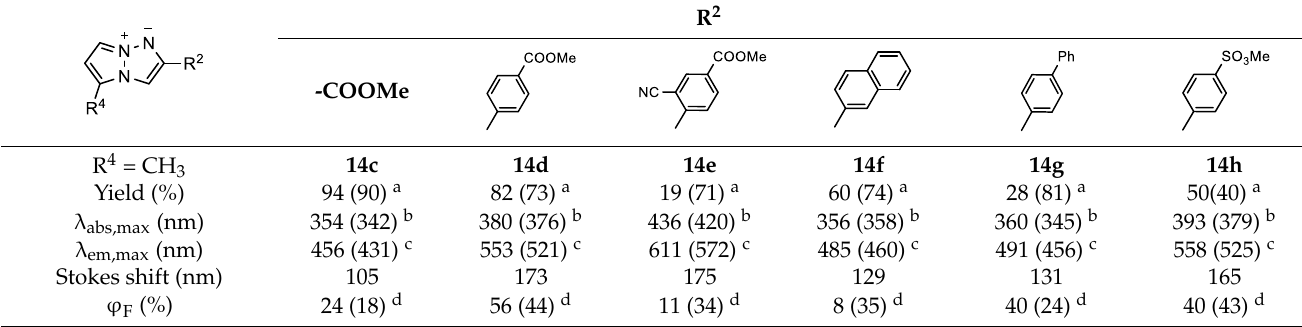
Table 4. Fluorescence properties and reaction yields of 2-substituted 4-methyl-TAPs 14c –h in DCM. R 2